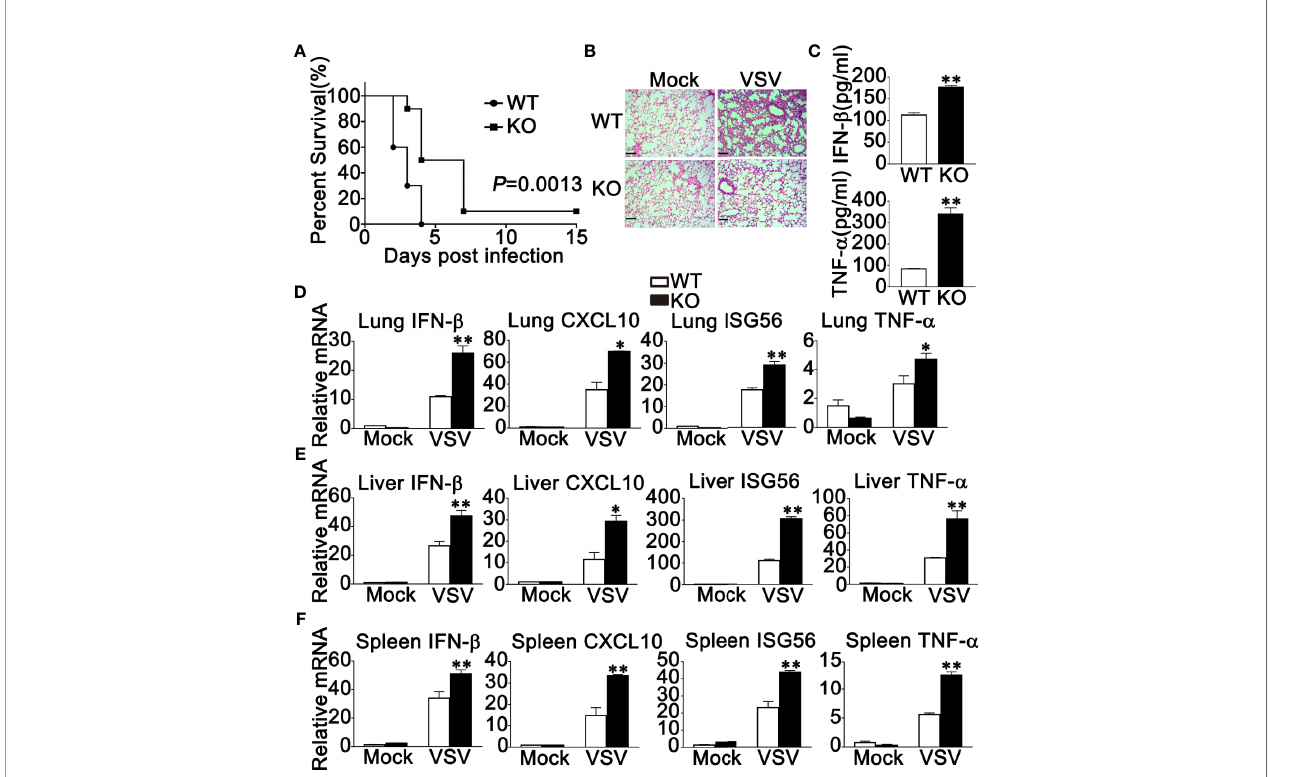
FIGURE 6 | RNF90 de fi ciency protects mice from RNA virus infection. (A) Sex and age-matched WT and RNF90-de fi cient (KO) mice (n = 5) were intraperitoneally (i.p.) infected with VSV [5×10 8 plaque-forming units (PFU)]. Mouse survival rates were observed and recorded for 15 days. The data were analyzed by Log-rank (Mantel-Cox) test. (B) Sex and age-matched WT and RNF90-de fi cient (KO) mice were intraperitoneally (i.p.) infected with VSV (5×10 7 PFU) for 24 h, and lung sections were analyzed by H&E staining. Scale bars, 200 m m. (C) ELISA of IFN- b and TNF- a in serum of WT and RNF90-de fi cient (KO) mice 6 h after intraperitoneal (i.p.) infection with VSV